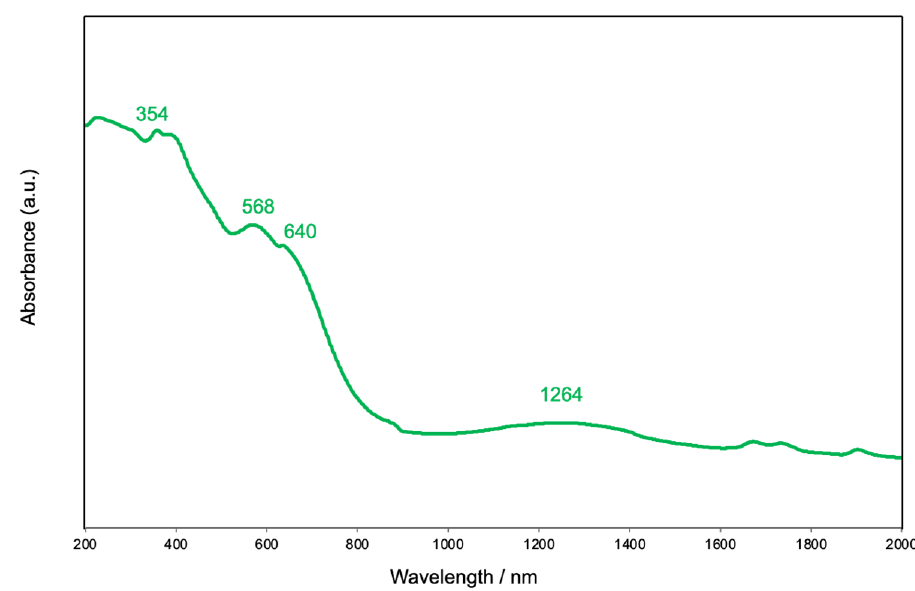
Figure 4. Diffuse reflectance spectra of [Co 3 (Hclsalpr) 2 (CH 3 COO) 4 ] (green line).